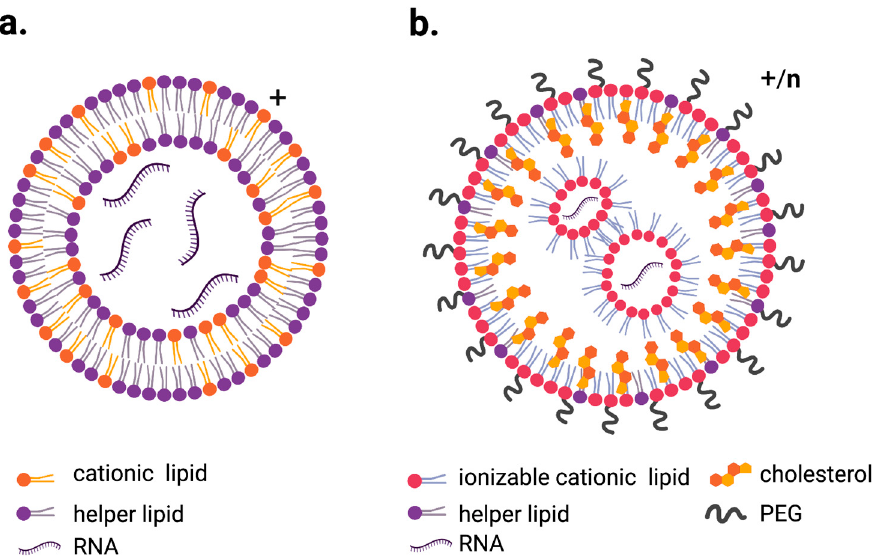
Figure 1. Schematic representation of the most commonly used LNPs for RNA delivery. ( a ). LNP containing cationic lipid (lipoplex) with overall positive charge, ( b ). ionizable lipid LNPs which exhibit positive charge while at low pH and more neutral charge when exposed to physiological pH. Figures created with BioRender.com.